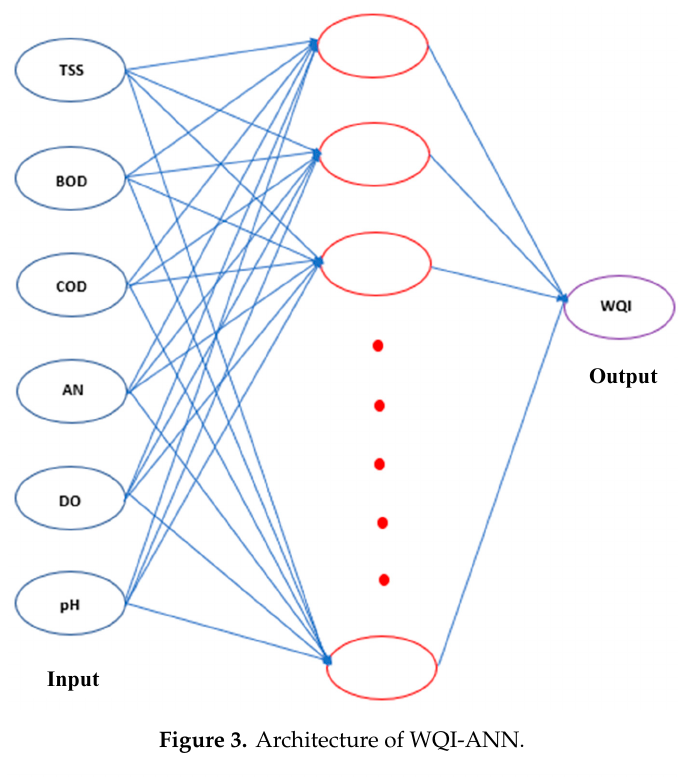
Figure 3. Architecture of WQI-ANN. Water 2020 , 12 , x FOR PEER REVIEW